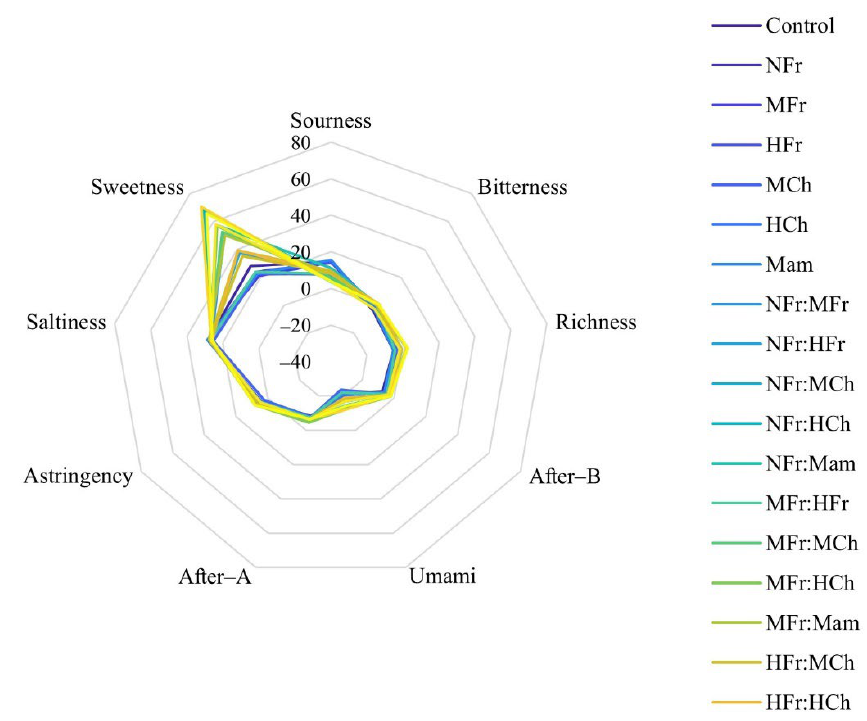
Figure 3. Taste radar graph of wine made from Vitis amurensis .